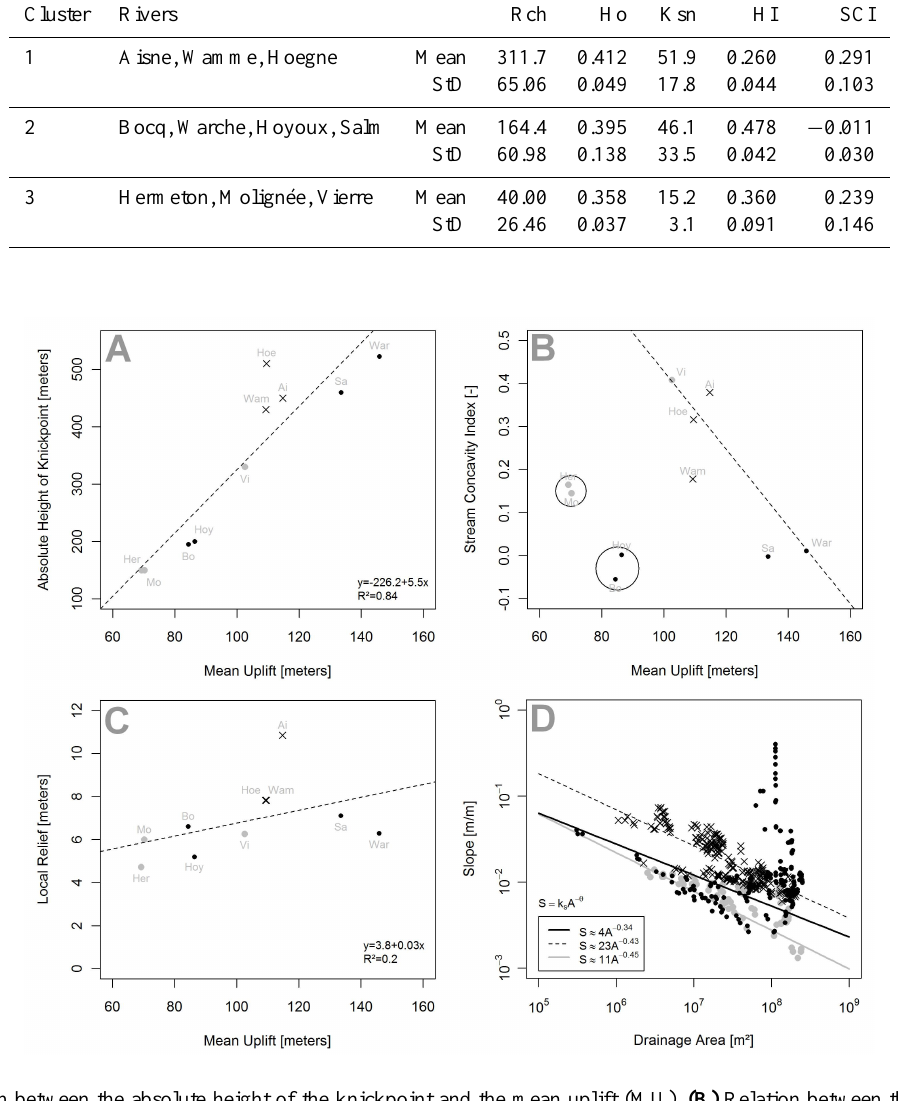
Fig. 3. (A) Relation between the absolute height of the knickpoint and the mean uplift (MU). (B) Relation between the stream concavity index and (SCI) and the mean uplift (MU). The dotted line represents the expected relationship between the two indices (C) Relation between the local relief (LRel) and the mean uplift (MU). (D) Illustration of the three cluster groups within the Slope-Area space. The black crosses represent the first cluster (Aisne, Wamme and Hoegne rivers), the black dots the second cluster (Bocq, Warche, Hoyoux and Salm rivers), and the grey dots represent the third cluster (Hermeton, Molign´ee and Vierre